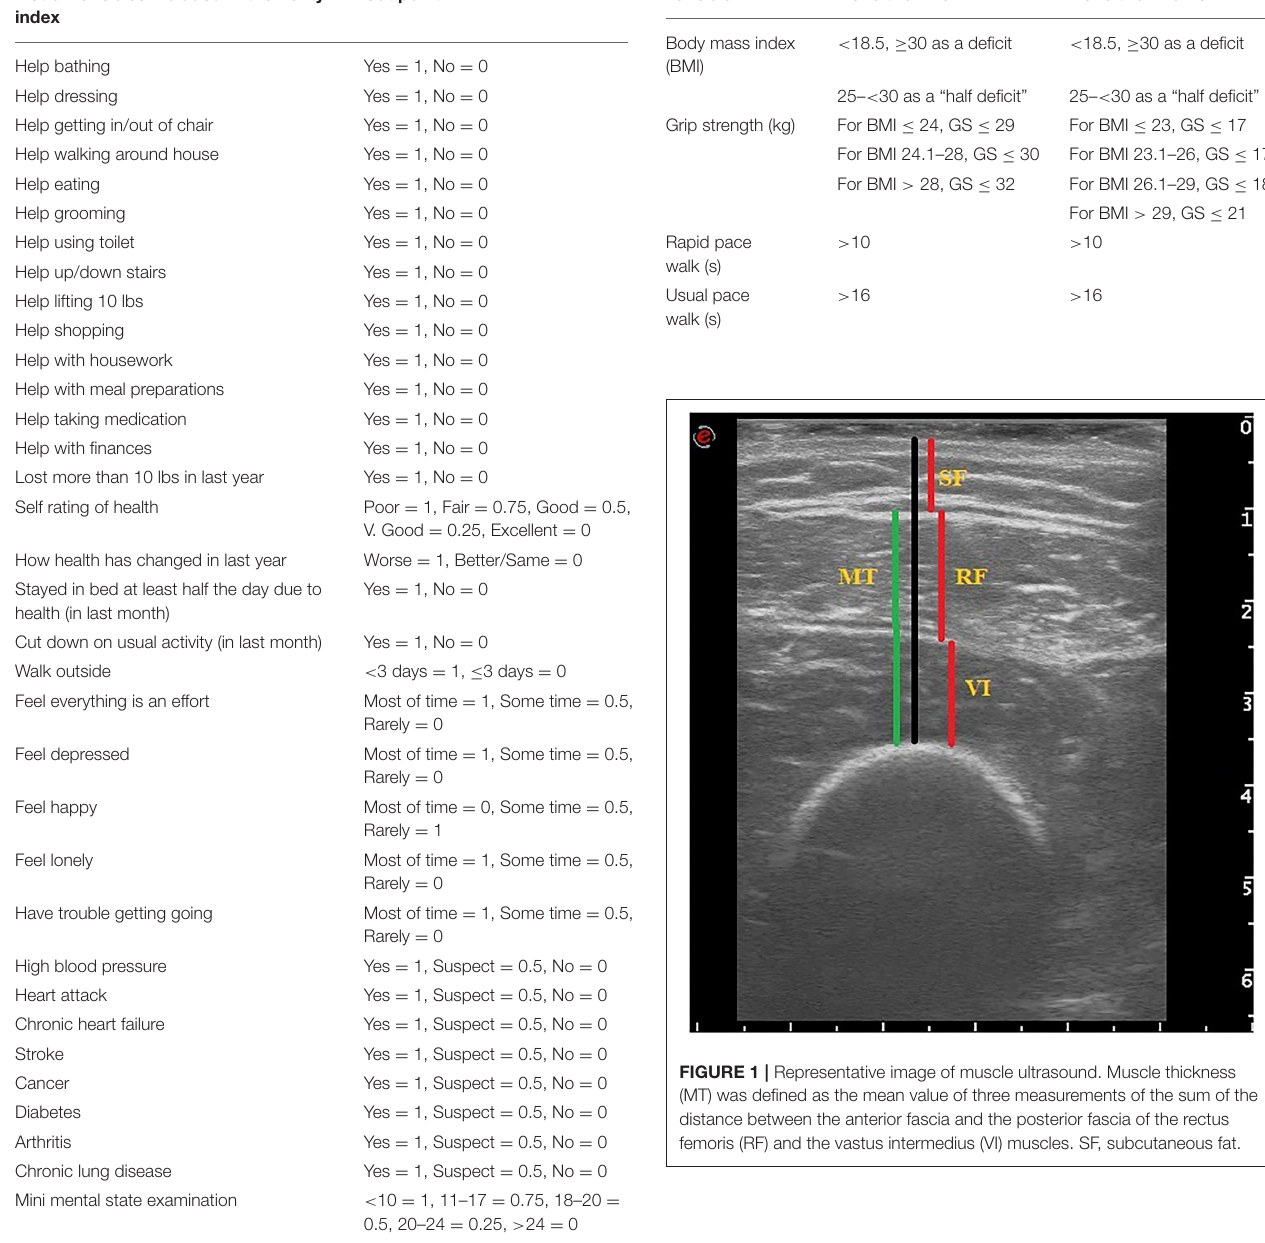
to identify factors associated with continuous dependent variable FI. Parsimonious selection criteria were used to avoid overfitting bias. The analysis considered: age, gender, and BMI as independent variables. An alternative model was developed with subcutaneous fat thickness as an independent factor, instead of BMI. The regression model was employed to determine the impact of the MUS parameters on FI. All analyses were performed using the STATA statistical software (STATA version 17; StataCorp LLC, College Station, TX, USA), and a p -value < 0.05 was considered as the statistical significance